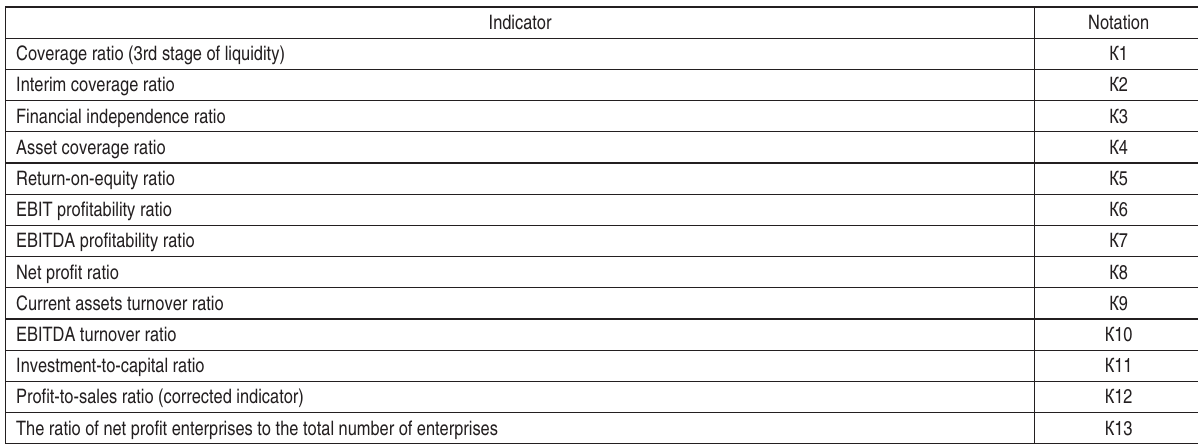
Table 1. The formation of the initial set of indicators